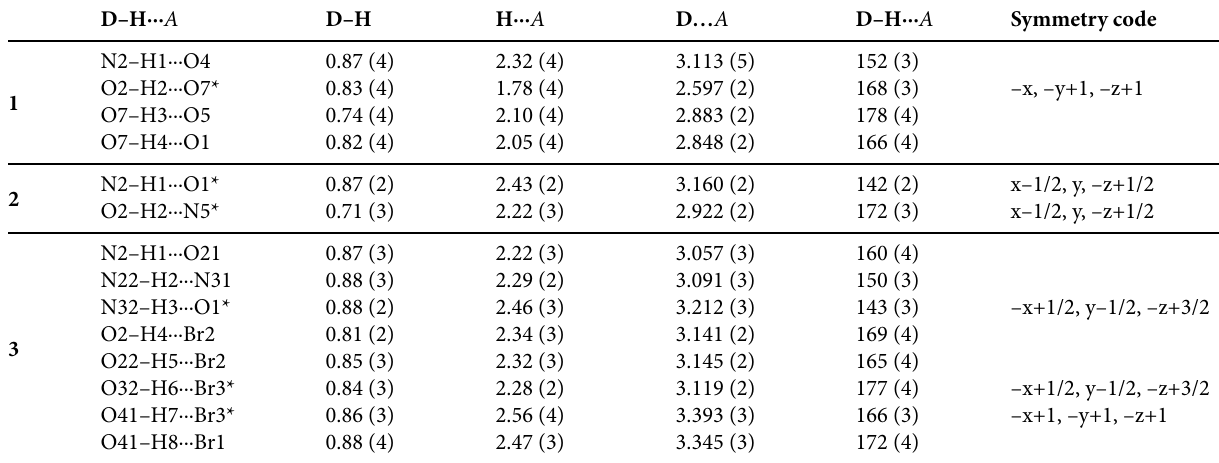
Table 3. Hydrogen bonding (Å) and angles (°) in copper